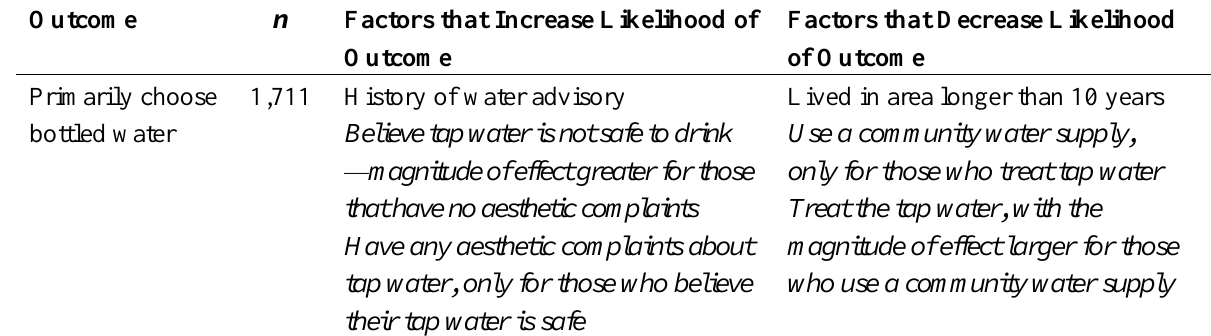
Table 6. Summary of the analyses for consuming primarily bottled water, consuming tap water daily and choosing to treat tap water, including the number of observations used and the risk factors associated with the final model for each outcome (effect modifications